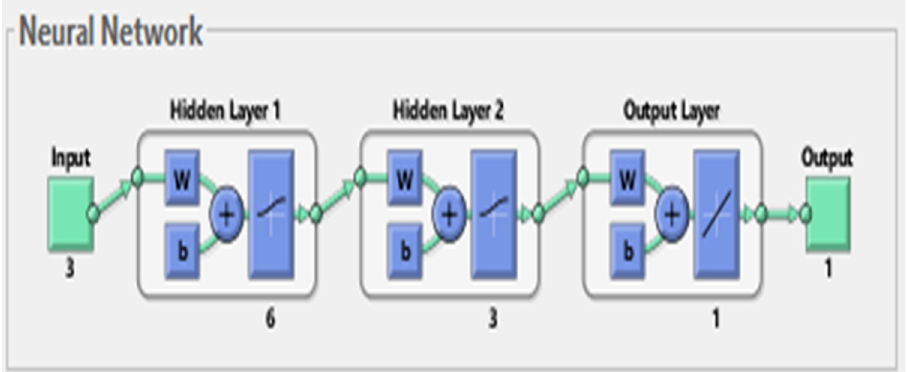
Figure 13. Design of the ANN network in Matlab R2020b toolbox.